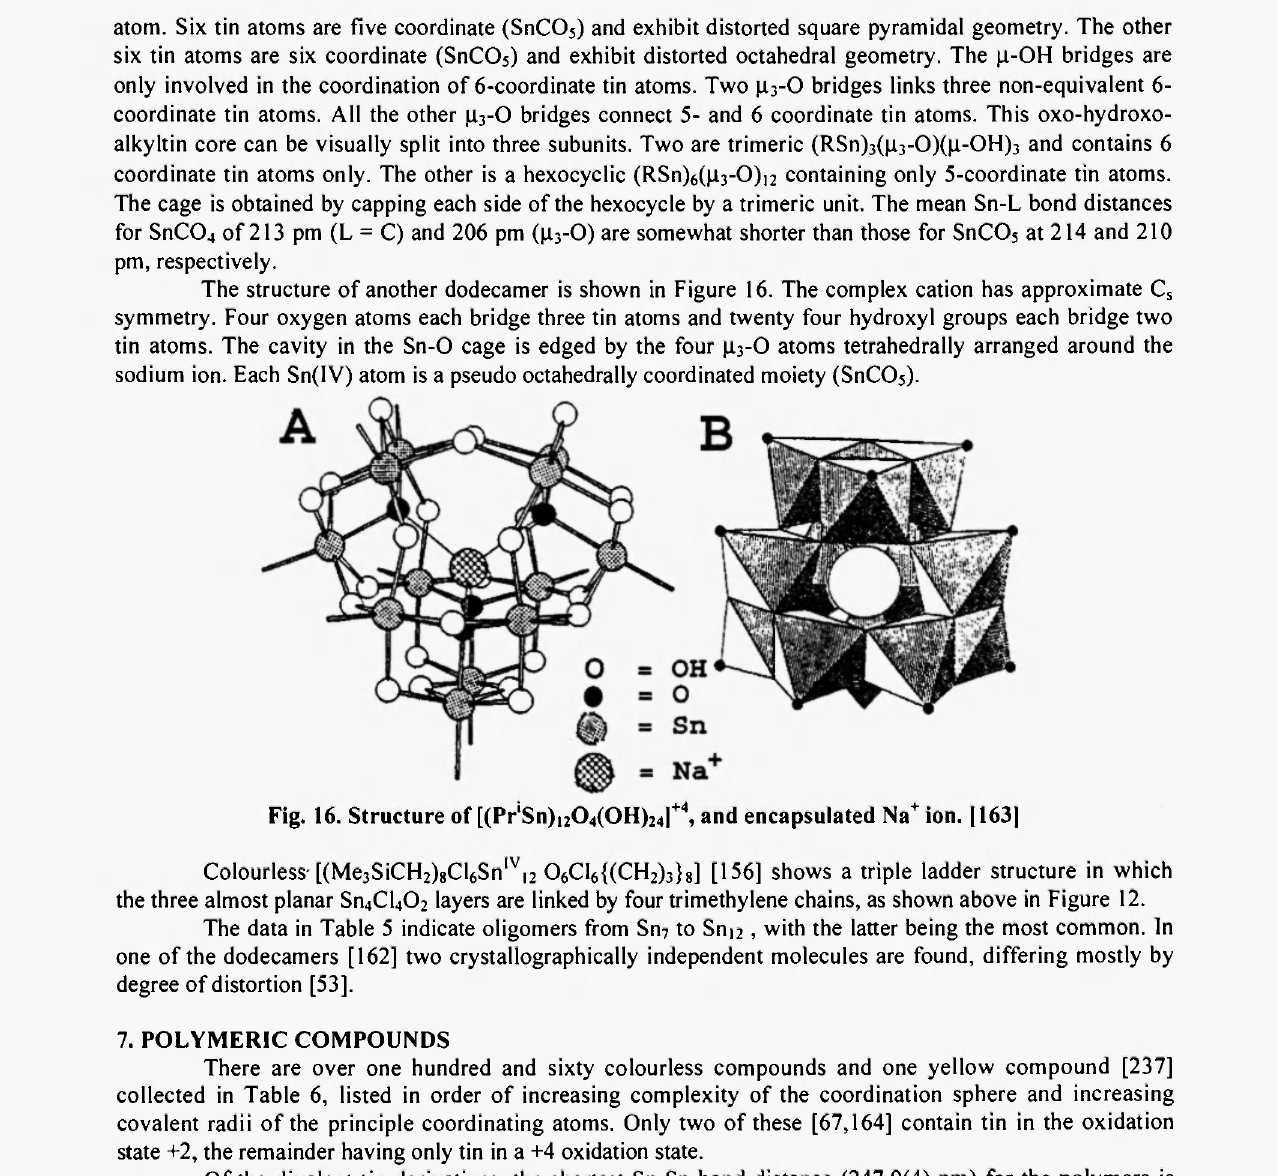
Fig. 16. Structure of [(Pr l Sn) 12 0 4 (0H)24| +4 , and encapsulated Na + ion.